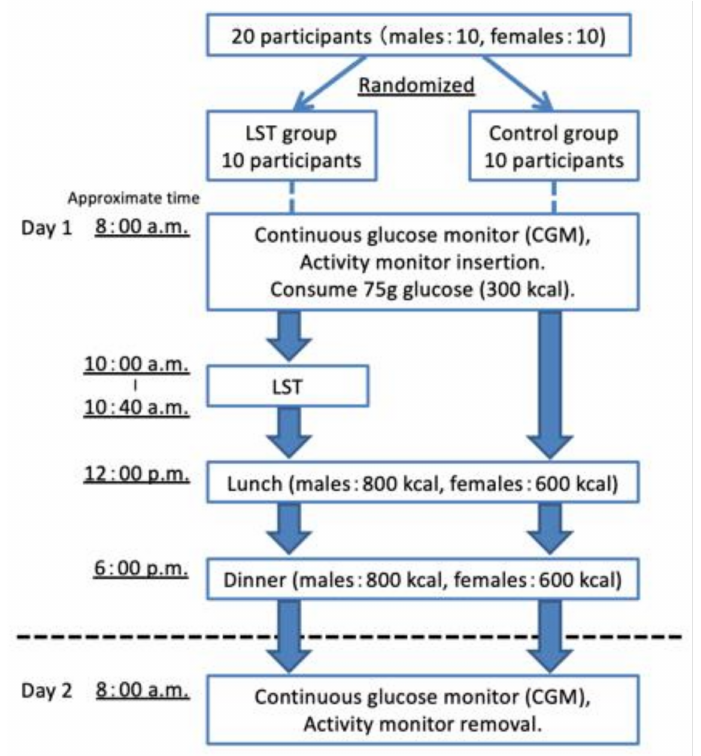
Figure 1. A flow chart of the subject recruitment, randomization, and study procedure. LST, low- intensity resistance exercise with slow movements and tonic force